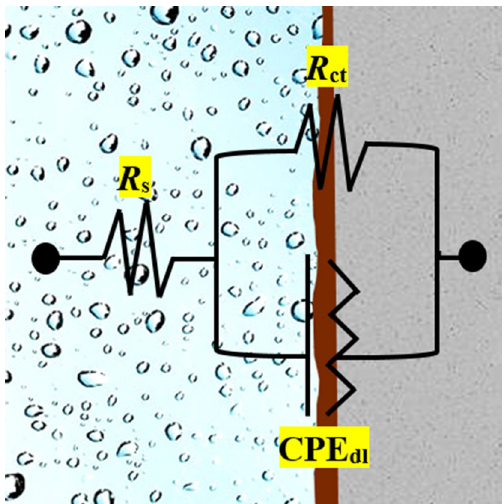
Figure 3. The equivalent electrical circuit employed for fitting EIS data shown in Fig. 2.